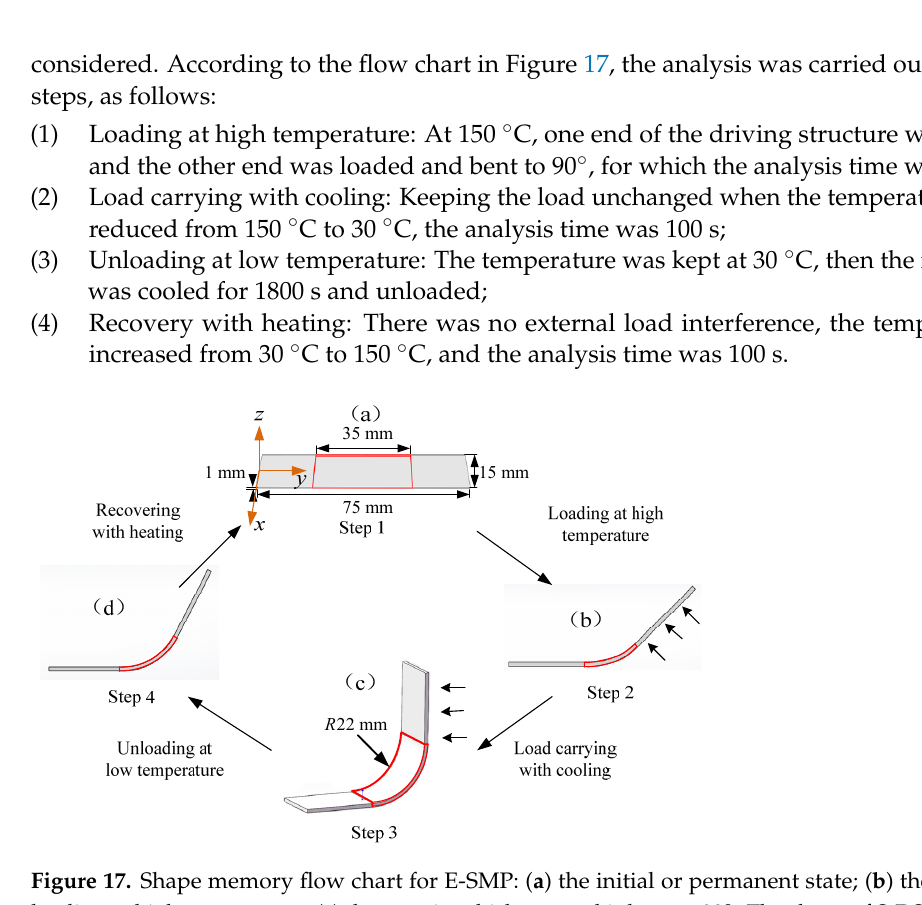
Figure 16. Verification of the grid independence.